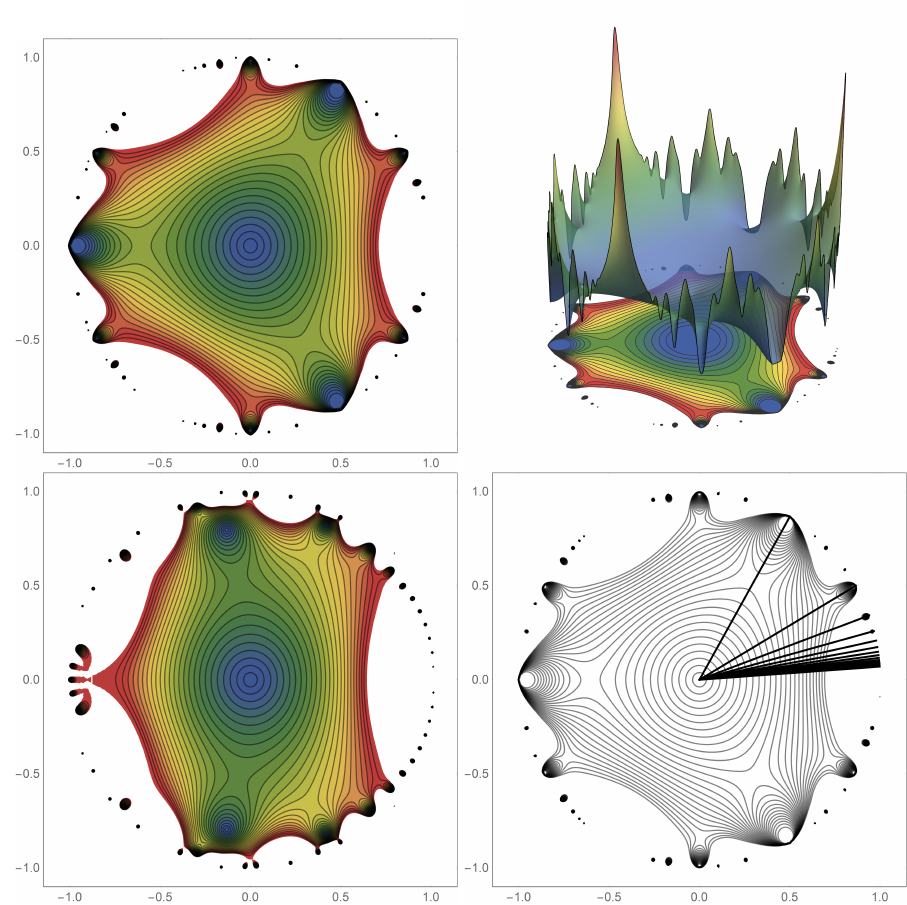
Figure 1. A particularly illustrative way to present graphs of L ( C ( k ) ; z ) . The representation shown here is especially useful for this work. The contour plot is truncated at the unity level set (blue shading represents low values and red shading represents high values). The top left panel shows the example of L ( C ( 3 ) ; z ) where a plot of | f 16 ( z ) | . The top right panel shows a superposition of the contour plot and a three-dimensional rendering. The truncated contour plot more clearly exposes the true rotational symmetry of the centered polygonal lacunary functions. The bottom left graph shows the case of L ( T n ; z ) , where T ( n ) are the well-known triangular numbers, again for | f 16 ( z ) | . Despite the intimate relationship between the centered polygonal numbers and the triangular numbers, the plots are strikingly different. The bottom right panel shows an unshaded contour plot of the same function shown in the left panel of Figure 1. The superimposed black lines indicate the symmetry angles. The first 15 symmetry angles are shown (see text for